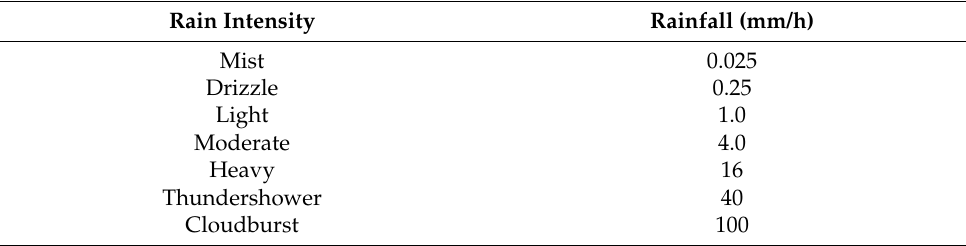
Table 7. Rain intensity characterization